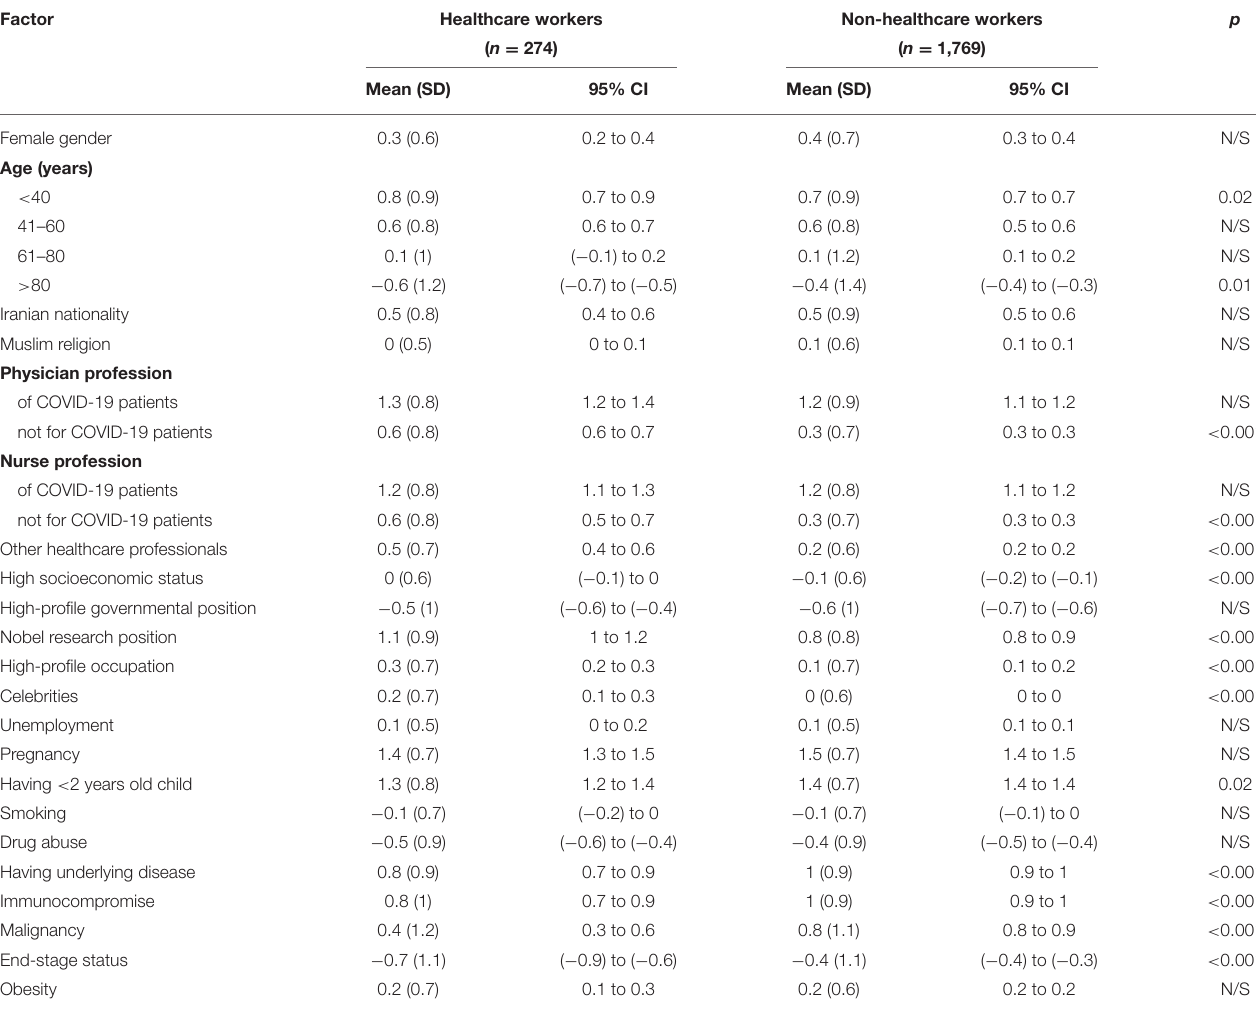
TABLE 5 | The mean priority score assigned to each sub-group of patients with COVID-19 among healthcare workers and non-healthcare workers. Factor Healthcare workers Non-healthcare